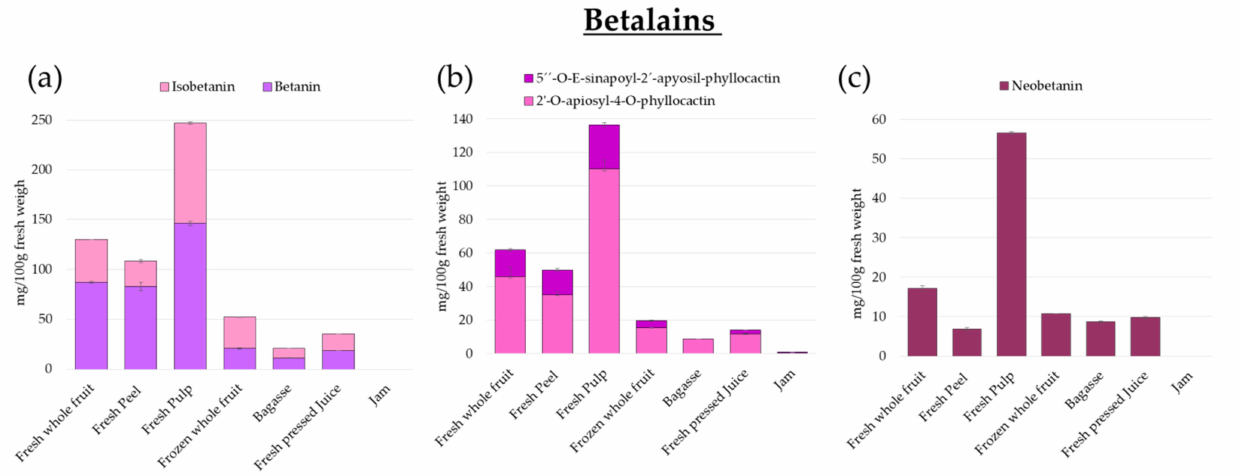
Figure 4. Betalains content (mg/100 g fresh weight) in Opuntia stricta var. Dillenii fruit tissues (peel, pulp, and whole fruit), jam production products (intermediate juice and jam), and by-product (bagasse); ( a ) betanin and isobetanin; ( b ) 2 (cid:48) -O-apiosyl-4-O-phyllocactin and 5”-O-E-sinapoyl-2 (cid:48) -apyosil-phyllocactin; ( c )